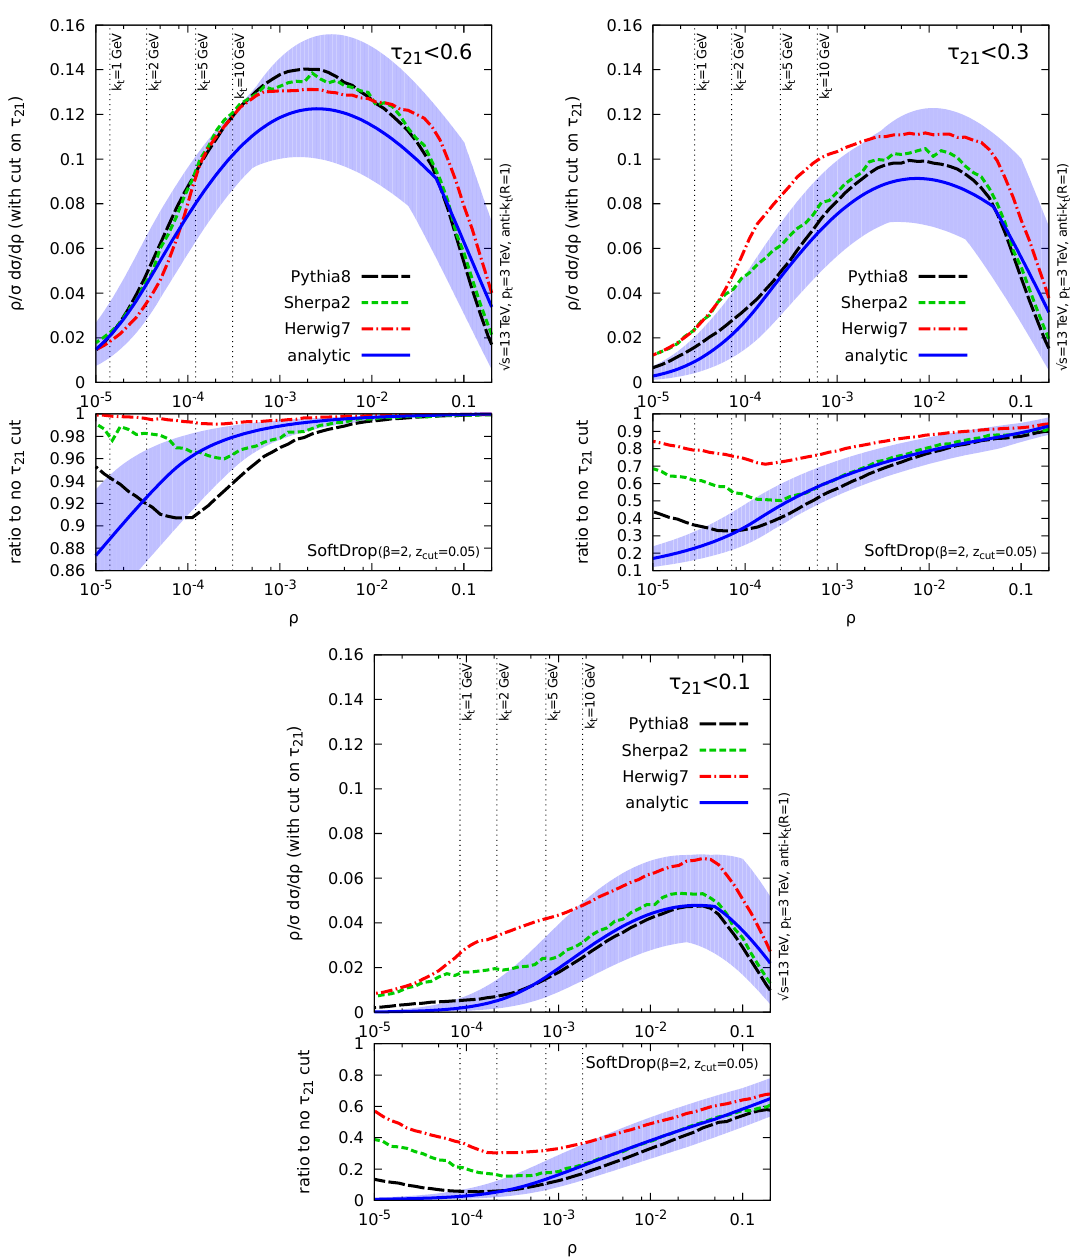
Figure 7 . Mass distribution with a cut on (cid:28) 21 compared to Monte Carlo for 3 di(cid:11)erent values of the cut. We show our analytic results (with their uncertainty band) compared to the Pythia8, Sherpa2 and Herwig7 generators. All results are for jets groomed with SoftDrop. The vertical dashed lines indicate when the scale (cid:26)(cid:28) starts to hit a given k t value, indicative of where non-perturbative e(cid:11)ects are expected to become dominant.